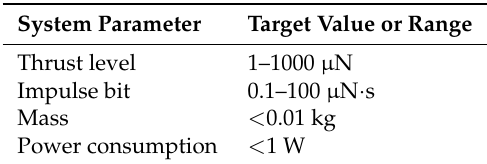
Table 1. Target Operating